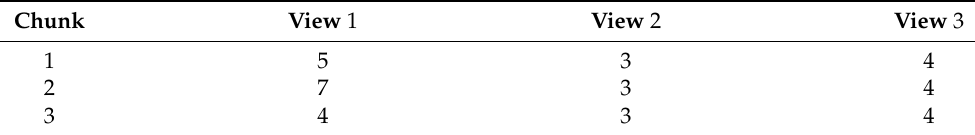
Table 2. Initial number of clusters in three chunks for each view—Heating System. Chunk View 1